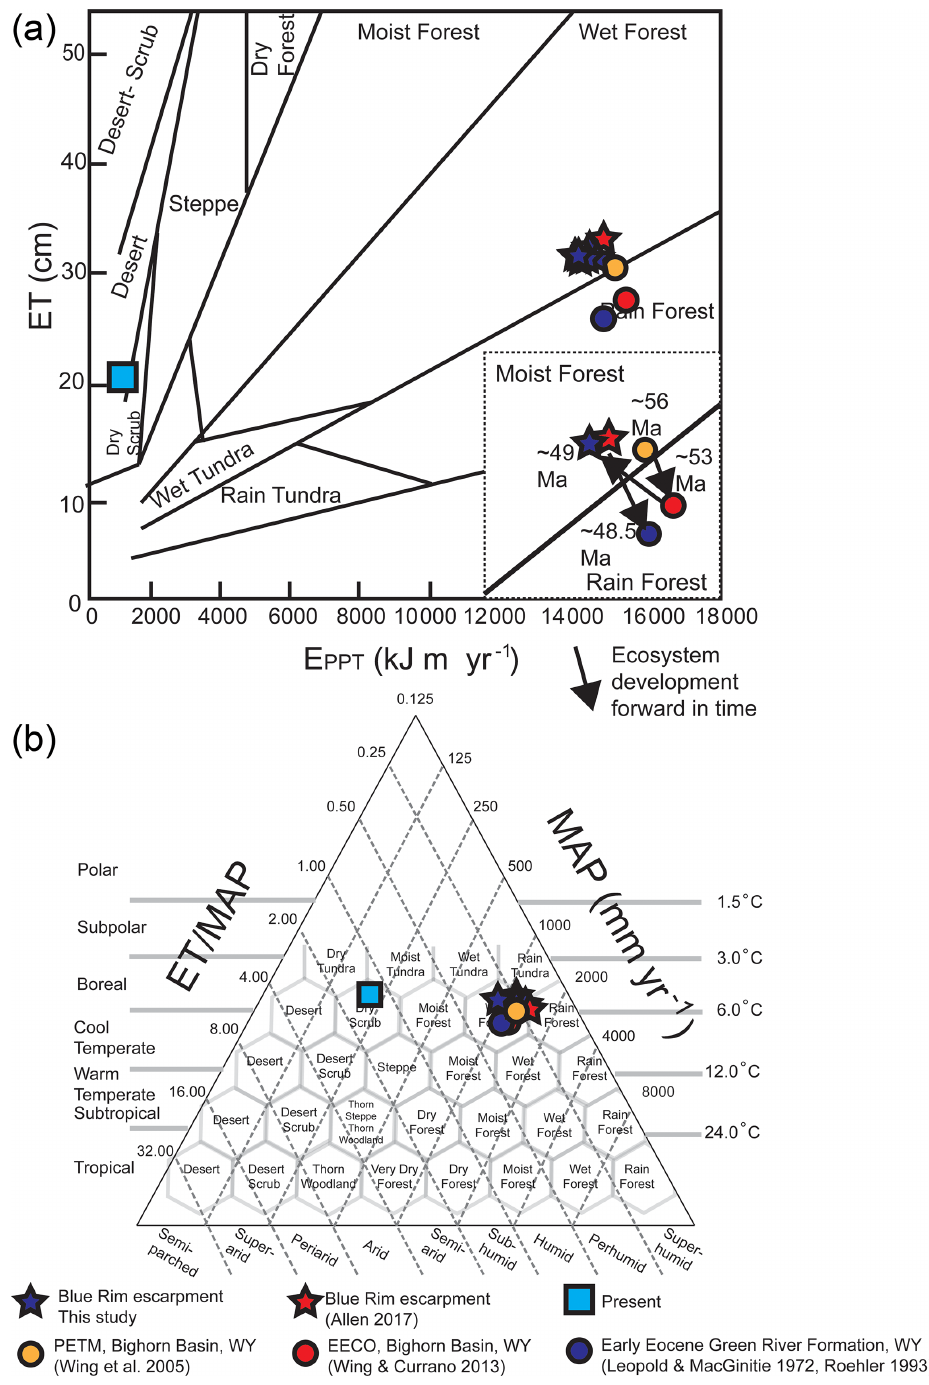
Figure 10. Ecosystem-level characterization of the Blue Rim escarpment and other Cenozoic Wyoming ecosystems. Paleosol-based (a) floral humidity province and (b) Holdridge life zones (Holdridge, 1967) show with blue stars. (a) Includes an inset showing climate progression over time, with (1) the PETM (Bighorn Basin, ∼ 56Ma), (2) the EECO (Bighorn Basin, ∼ 53Ma), (3) this site ( ∼ 49Ma), and (4) the latest stage of Lake Gosiute (Green River Formation, ∼ 48.5Ma; Smith et al., 2008). Comparative studies for this region based on nearby temperature and precipitation reconstructions are shown with yellow, red, and blue circles, while the climate of the present (as measured in Rock Springs, Wyoming, USA) is shown as light blue squares. Average values from Allen (2017b) using leaf margin analysis to reconstruct MAAT and leaf area analysis to reconstruct MAP are shown by red